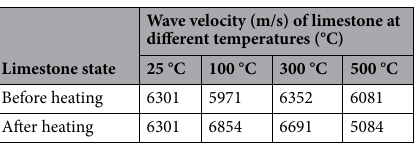
Table 2. Wave velocity changes of limestone before and after heating at different